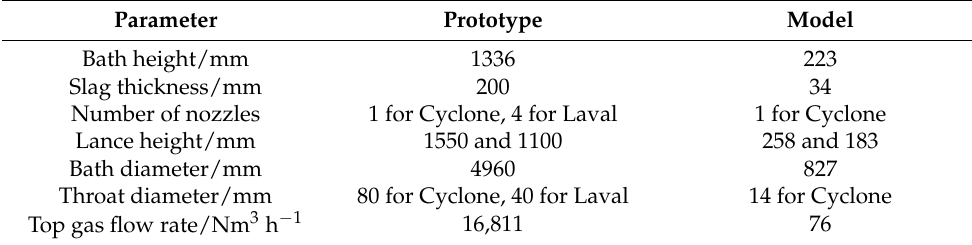
Table 1. Parameters of prototype and physical model.